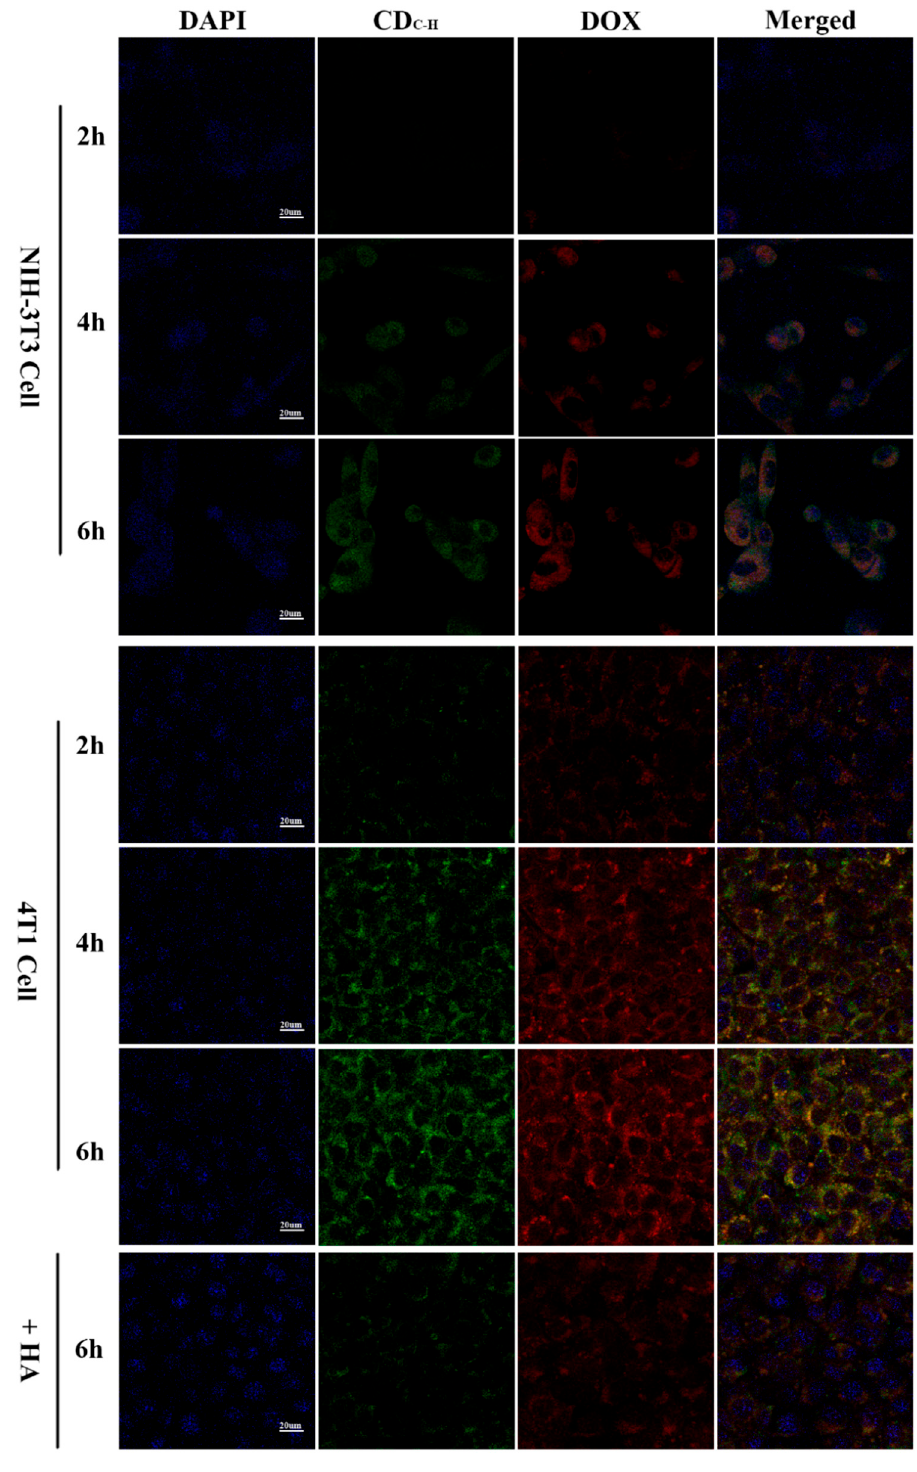
Figure 7. CLSM images of NIH-3T3 and 4T1 cells pretreated with DOX–CD C-H complexes for 2, 4 and 6 h at 37 °C, under excitations of 405, 488 and 514 nm, and emissions at 447, 525 and 580 nm, respectively. The competitive inhibition experiments were performed by treating 4T1 cells with free HA (10 mg/mL) before adding DOX–CD C-H complexes. Scale bars: 20 µm.